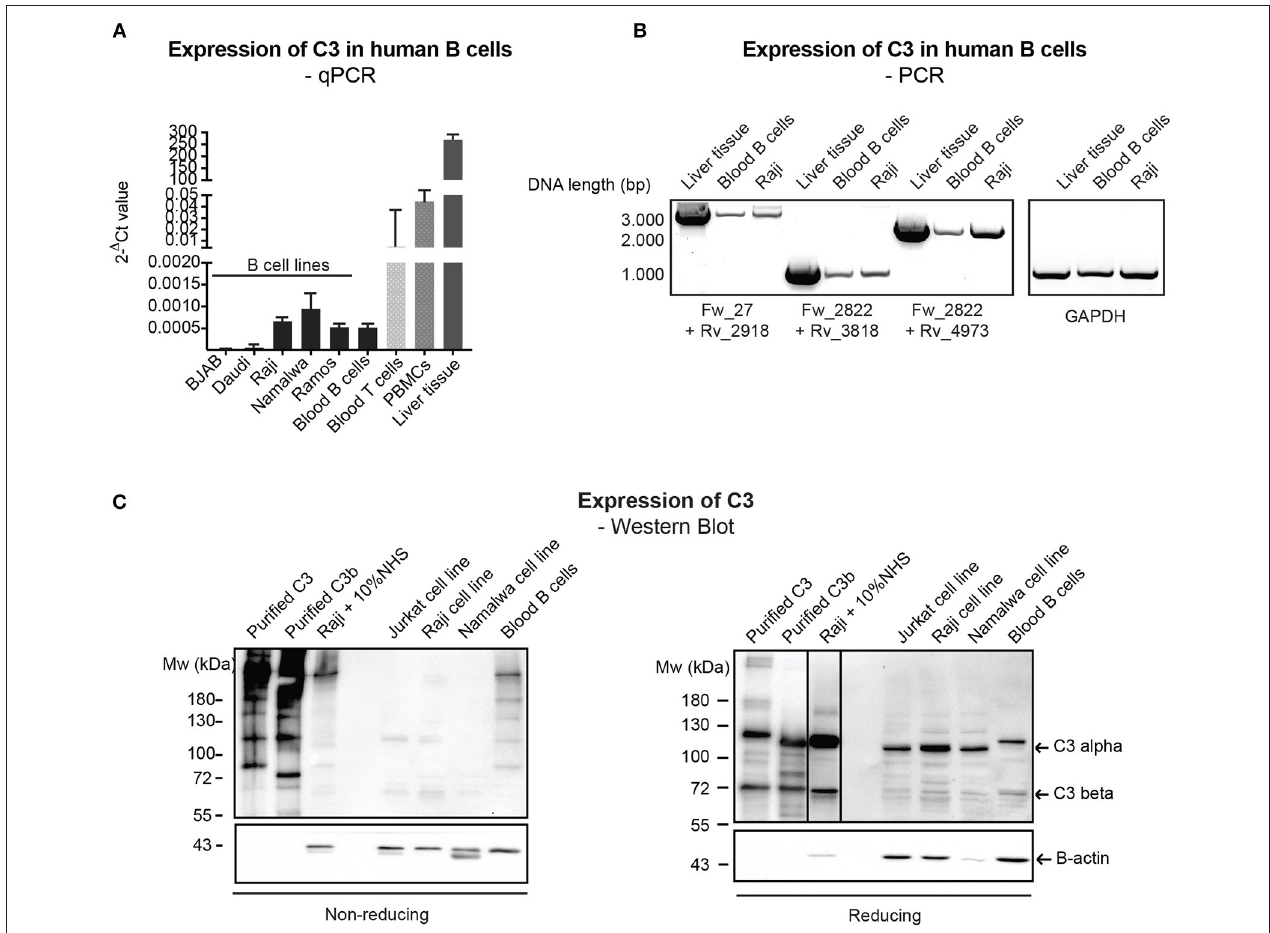
FIGURE 1 | Endogenous expression of C3 is very low in human B cells. (A) RNA was isolated from malignant B cell lines and blood-derived B cells, reverse-transcribed and analyzed for C3 expression by qPCR. As positive control, blood-derived T cells, PBMCs, and total, liver tissue RNA were used. Data were normalized to the housekeeping HPRT gene and are shown as mean 2-dCt values with SD of three independent experiments. (B) The presence of full length C3 mRNA was confirmed by primer pairs, covering the whole region of human C3 coding sequence. As positive control, liver tissue RNA was used. Data shown are representative of three independent experiments. Numbers indicate DNA length in base pair (bp). The start positions of forward (Fw) and reverse (Rv) primers are shown under the gel picture. (C) Western blot results analyzing endogenous C3 expression of human B cells. Lysates prepared from the human B cell lines, Raji and Namalwa and blood-derived B cells and PBMCs were analyzed for the presence of C3 by Western blot with the goat polyclonal anti-C3 antibody from Quidel under non reducing and reducing conditions. As positive control, lysate of Raji cells incubated with 10% NHS in EDTA-GVB buffer was used. Results shown are representative of five independent